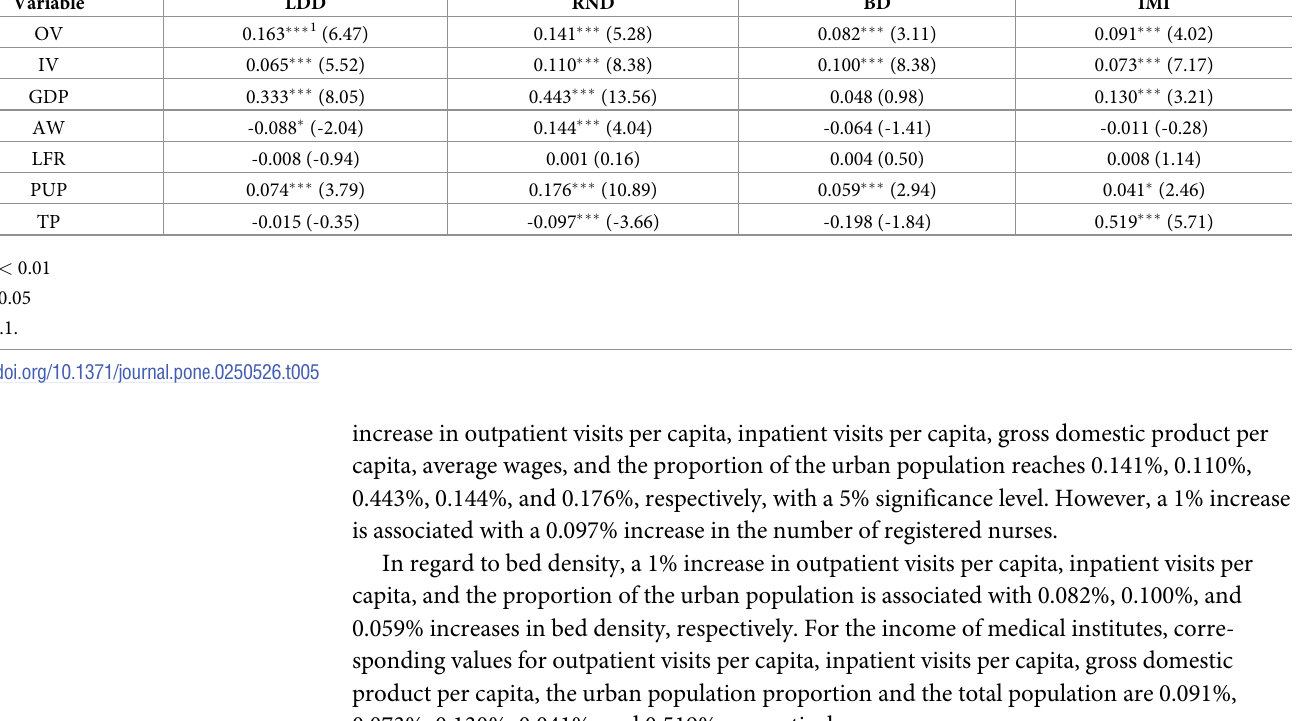
Table 5. Direct effects of the independent variables on health resources.